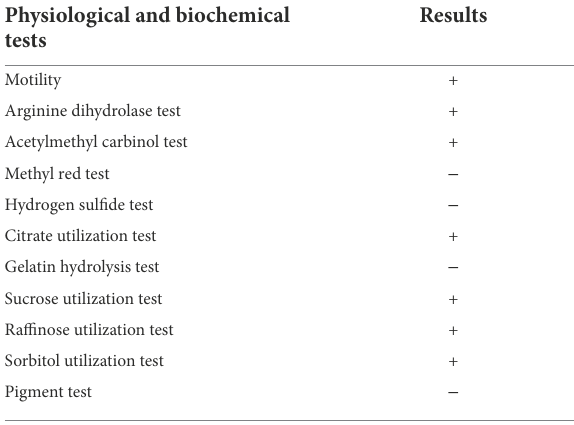
TABLE 1 Biochemical characterization of the Enterobacter cloacae NG-33 strain. Physiological and biochemical